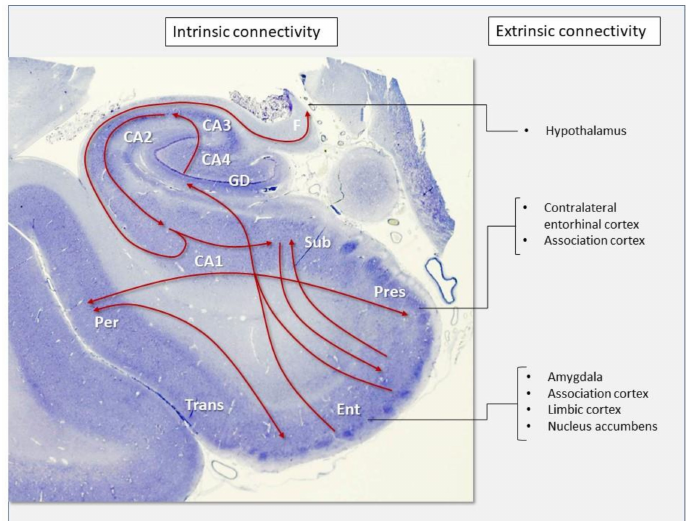
Figure 7. Macroscopic image of the hippocampal formation from a normal control subject, coro- nal section, Nissl stain. The main pathways of intrinsic and extrinsic connectivity are depicted. Per , perirhinal cortex. Trans , transentorhinal cortex. Ent , entorhinal cortex. Pres , presubiculum. Sub ,